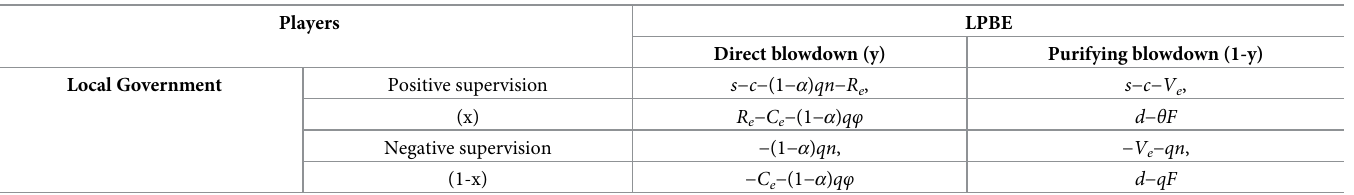
Table 2. Game payment matrix of government and